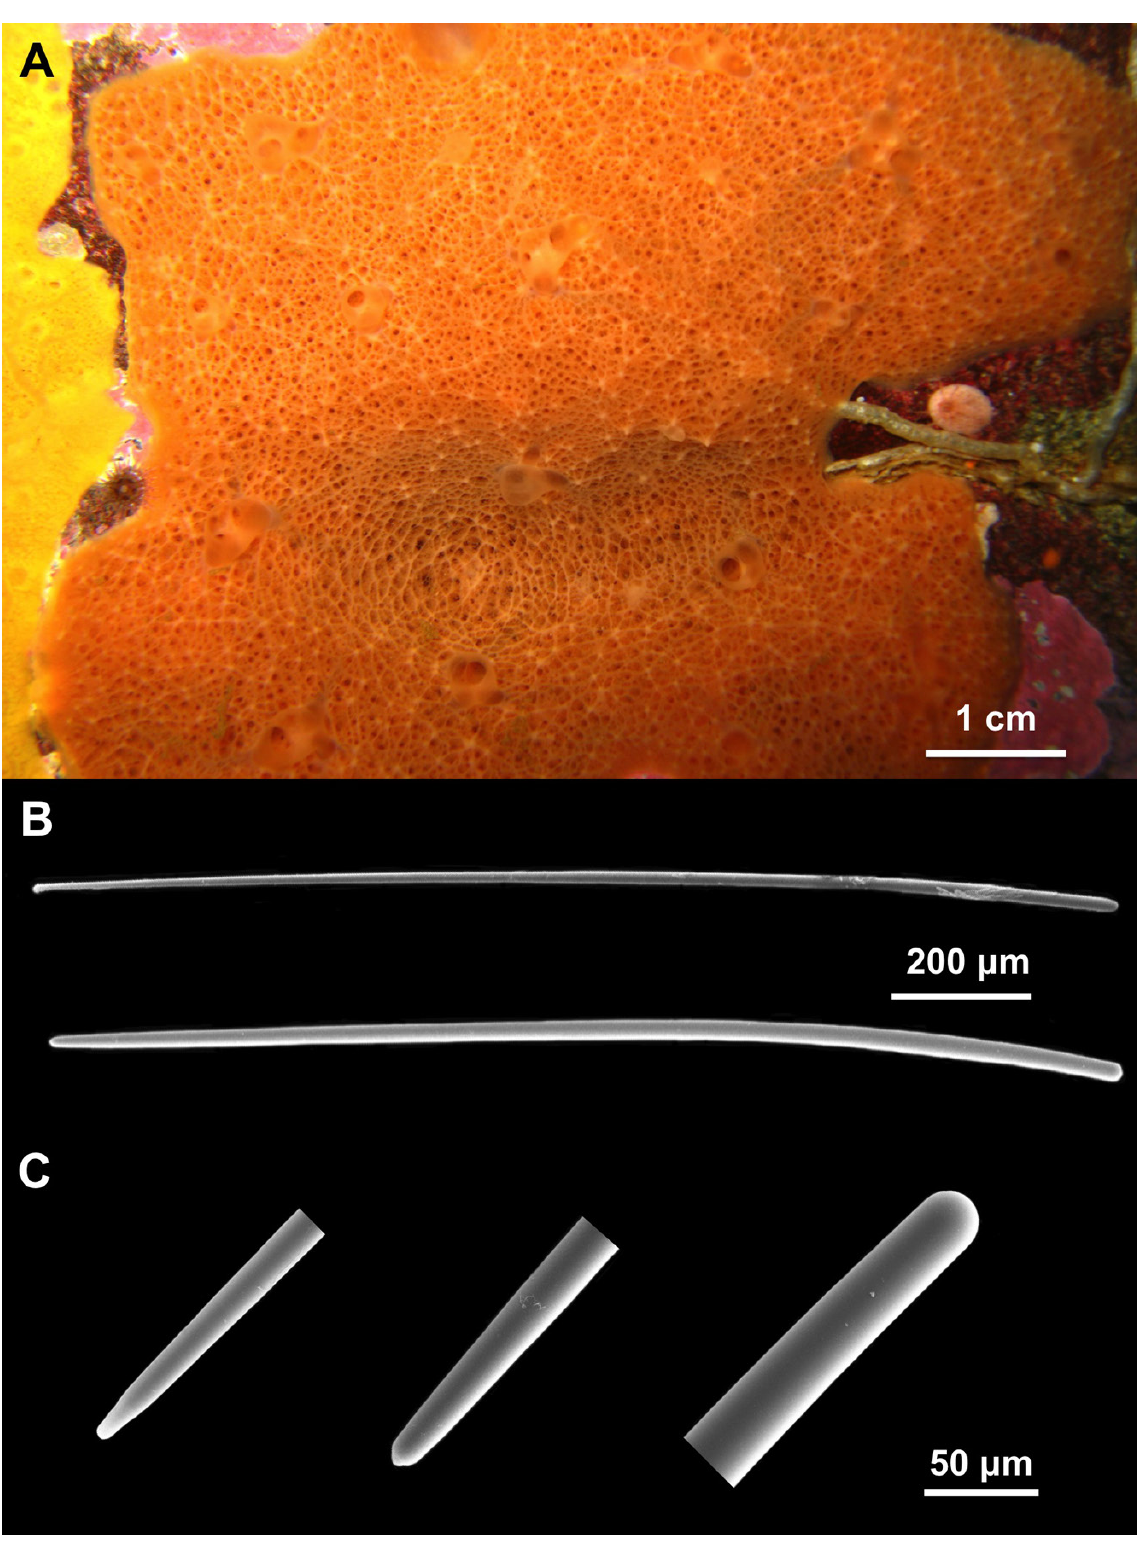
Fig. 13. Scopalina cribrosa Bertolino, Costa & Pansini sp. nov., holotype (CILE 32; MSGN 61498). A . The holotype in life. B . Styles. C . Magnification of the style